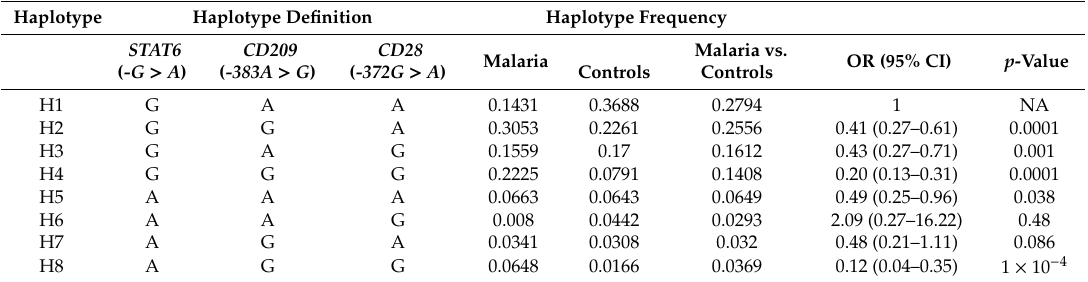
Table 4. Estimated haplotype frequencies of the selected loci between the malaria-infected and control groups.